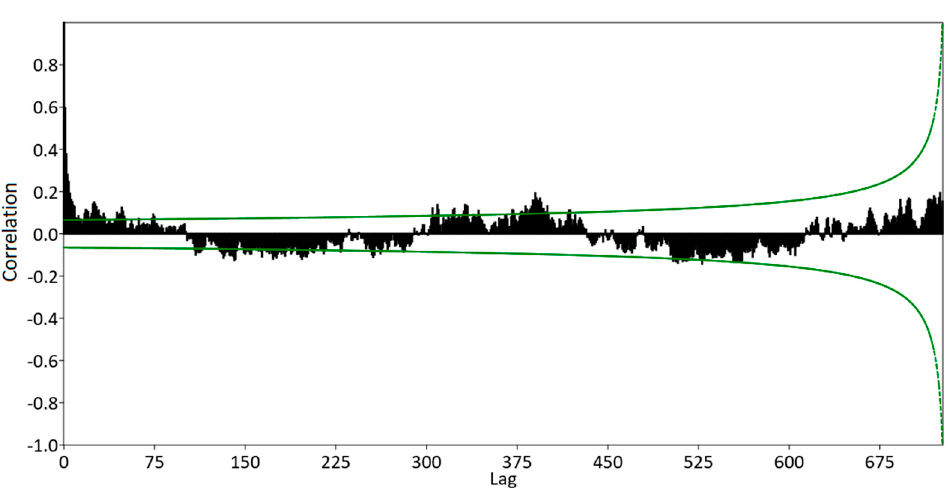
Figure 4. Autocorrelation analysis of the wind time series plotted against the mean of the four-year series.